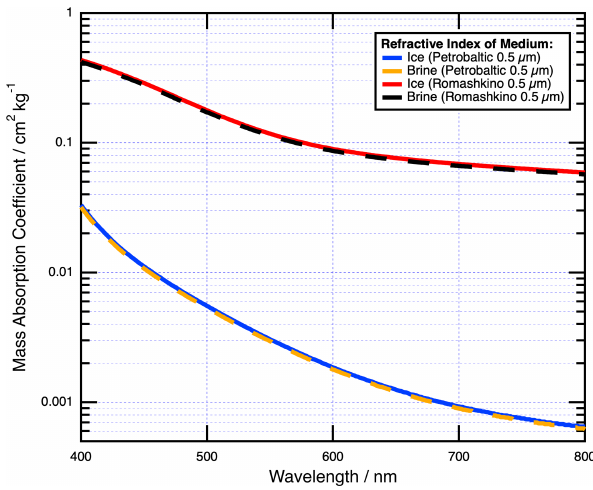
Figure 7. Mass absorption coefficient of Romashkino and Petrobaltic oils with a median droplet radius of 0.5µm in a medium of pure sea ice (Warren and Brandt, 2008) and a medium of brine (Quan and Fry, 1995). These data demonstrate that the mass ab- sorption coefficient is independent of location (i.e. within the brine channel or ice